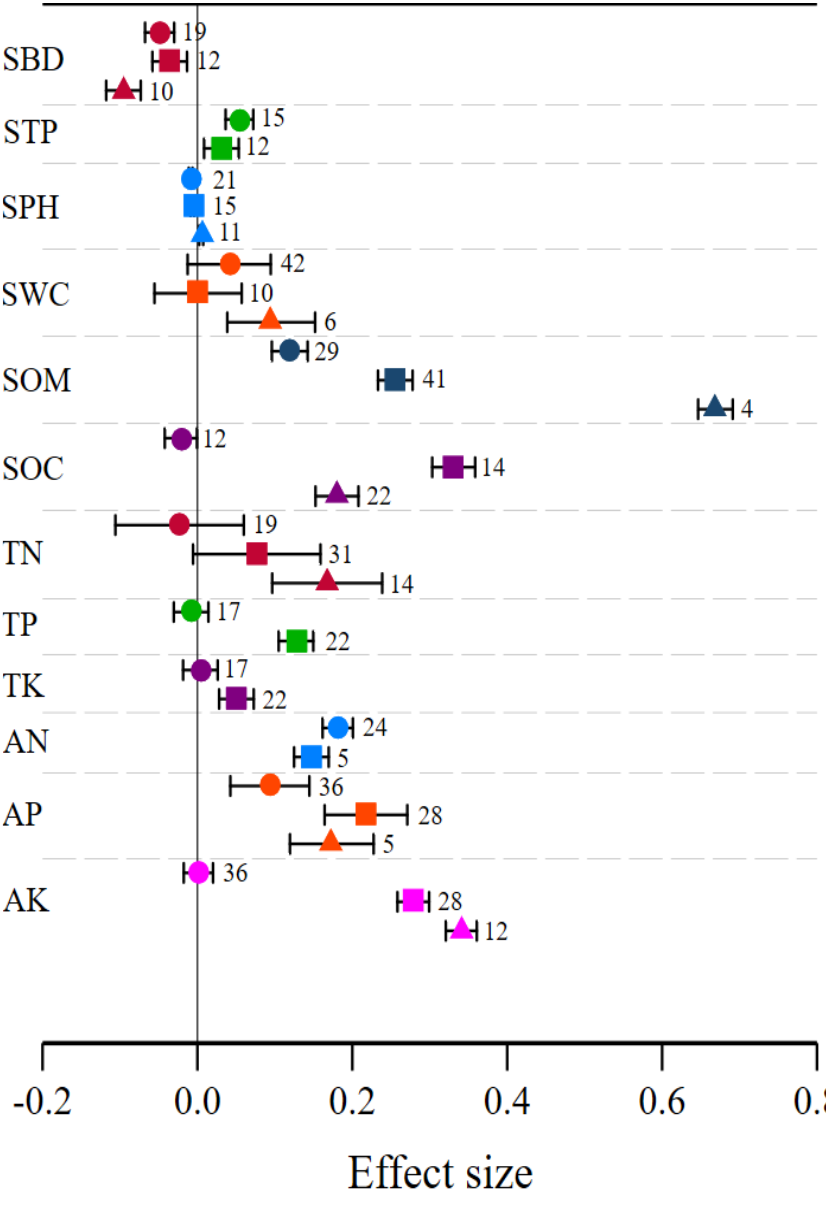
Figure 3. Effects of continuous grass − growing years on soil physicochemical properties of apple orchards in China. The circles represent the initial stage (<3 years), the squares represent the mid − term (3 − 5 years) and the triangles represent the long − term (>5 years). Weighted means and their 95% confidence intervals of the effect sizes are given. The numbers on the right side of the confidence intervals represent the sample sizes. SBD: soil bulk density; STP: soil total porosity, SPH: soil pH; SWC: soil water content; SOM: soil organic matter; SOC: soil organic carbon; TN: